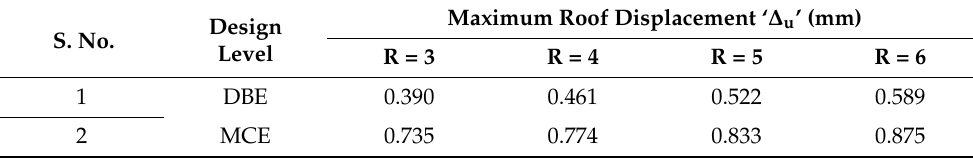
Table 10. Direct damage–loss ratio under unidirectional loading.